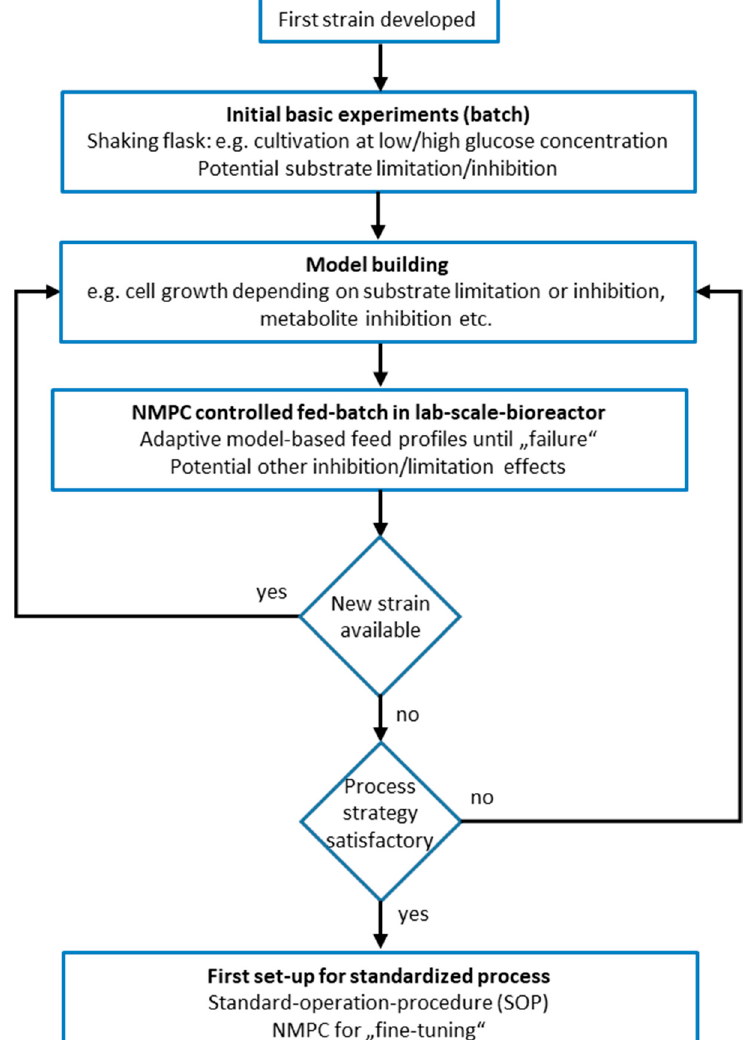
Figure 2. Schematic overview of the NMPC-assisted workflow for process development.